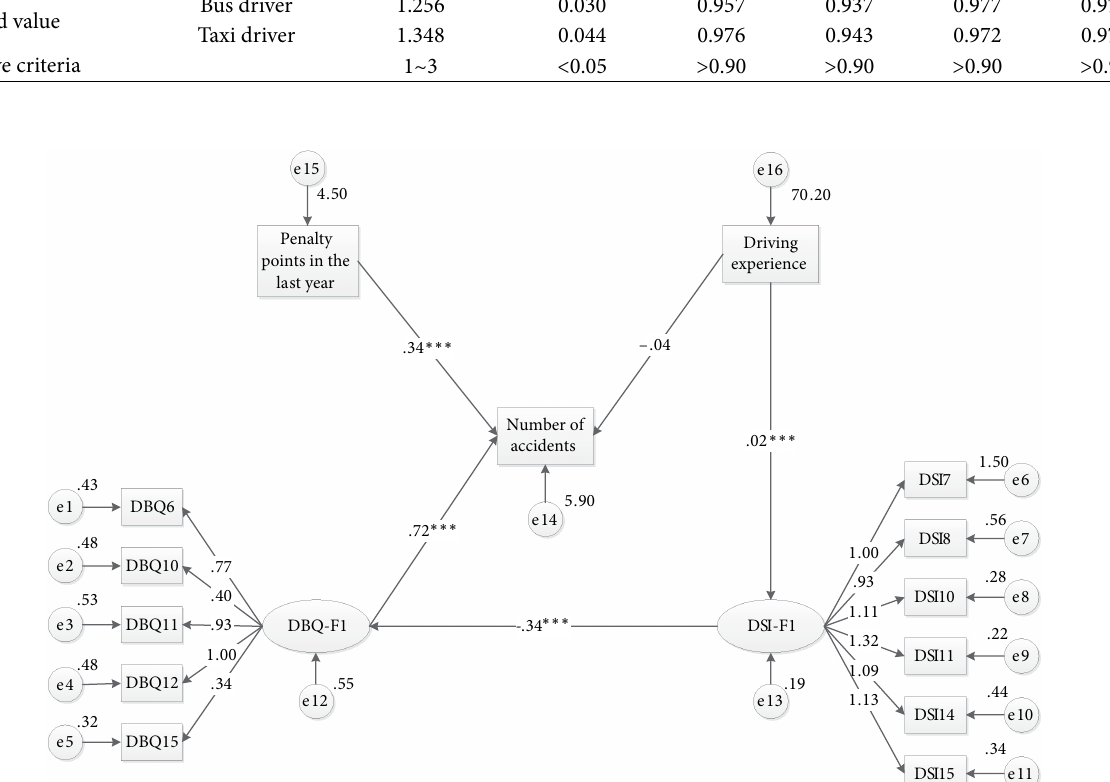
Figure 1: Bus driver structural equation model